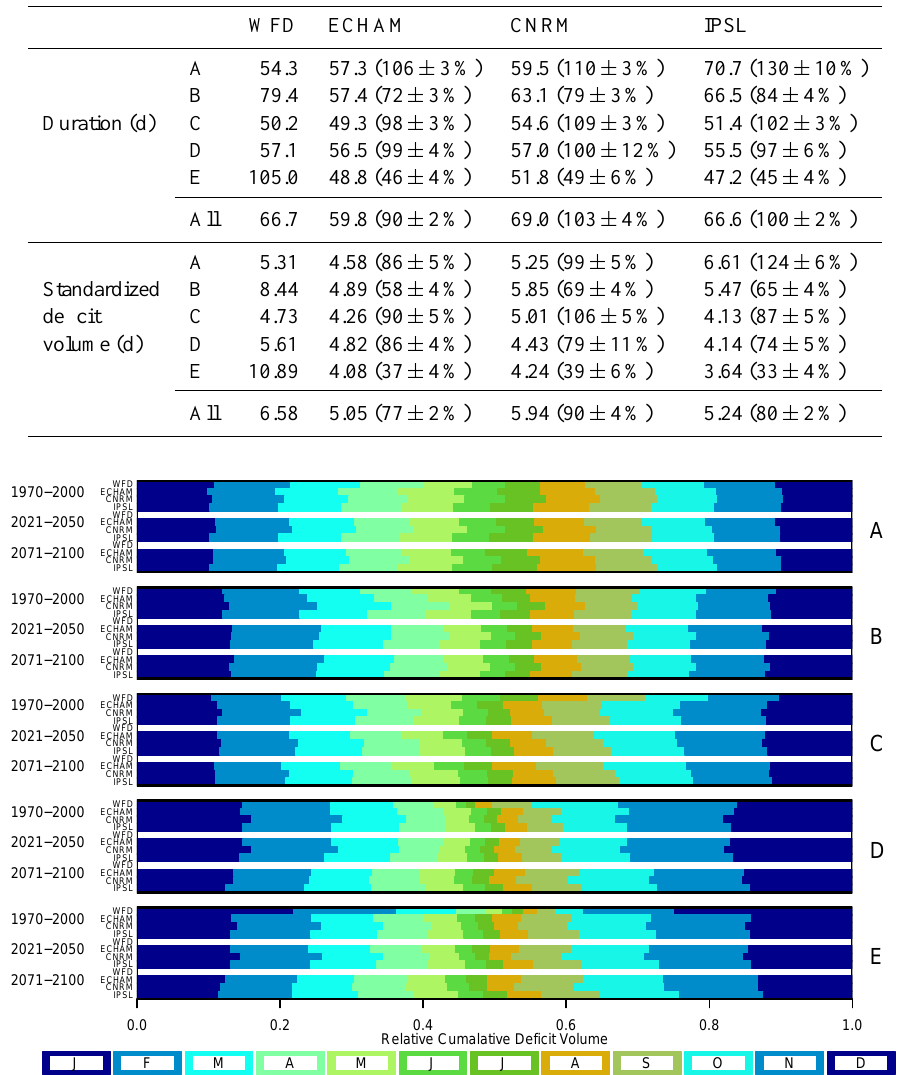
Table 3. Average hydrological drought characteristics for the control period (1971–2000), including relative difference for the three GCMs, relative to the WATCH Forcing Data and the standard deviation of the relative difference, derived from a two-sided t -test. Characteristics are provided for Equatorial (A), Arid (B), Warm temperate (C), Snow (D) and Polar climates (E).